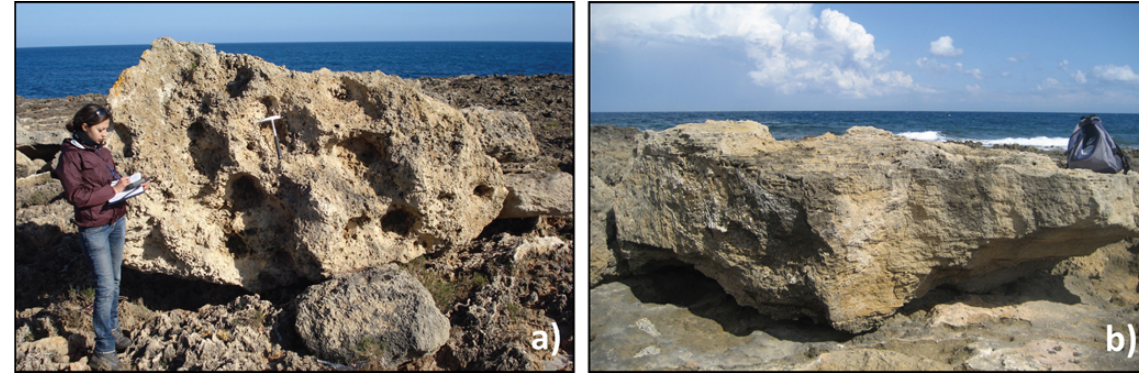
Fig. 5. Pictures of two (a, b) boulders, found at Vendicari site, lying at a distance beyond the limit of the local maximum-expected storm waves and interpreted as deposited by